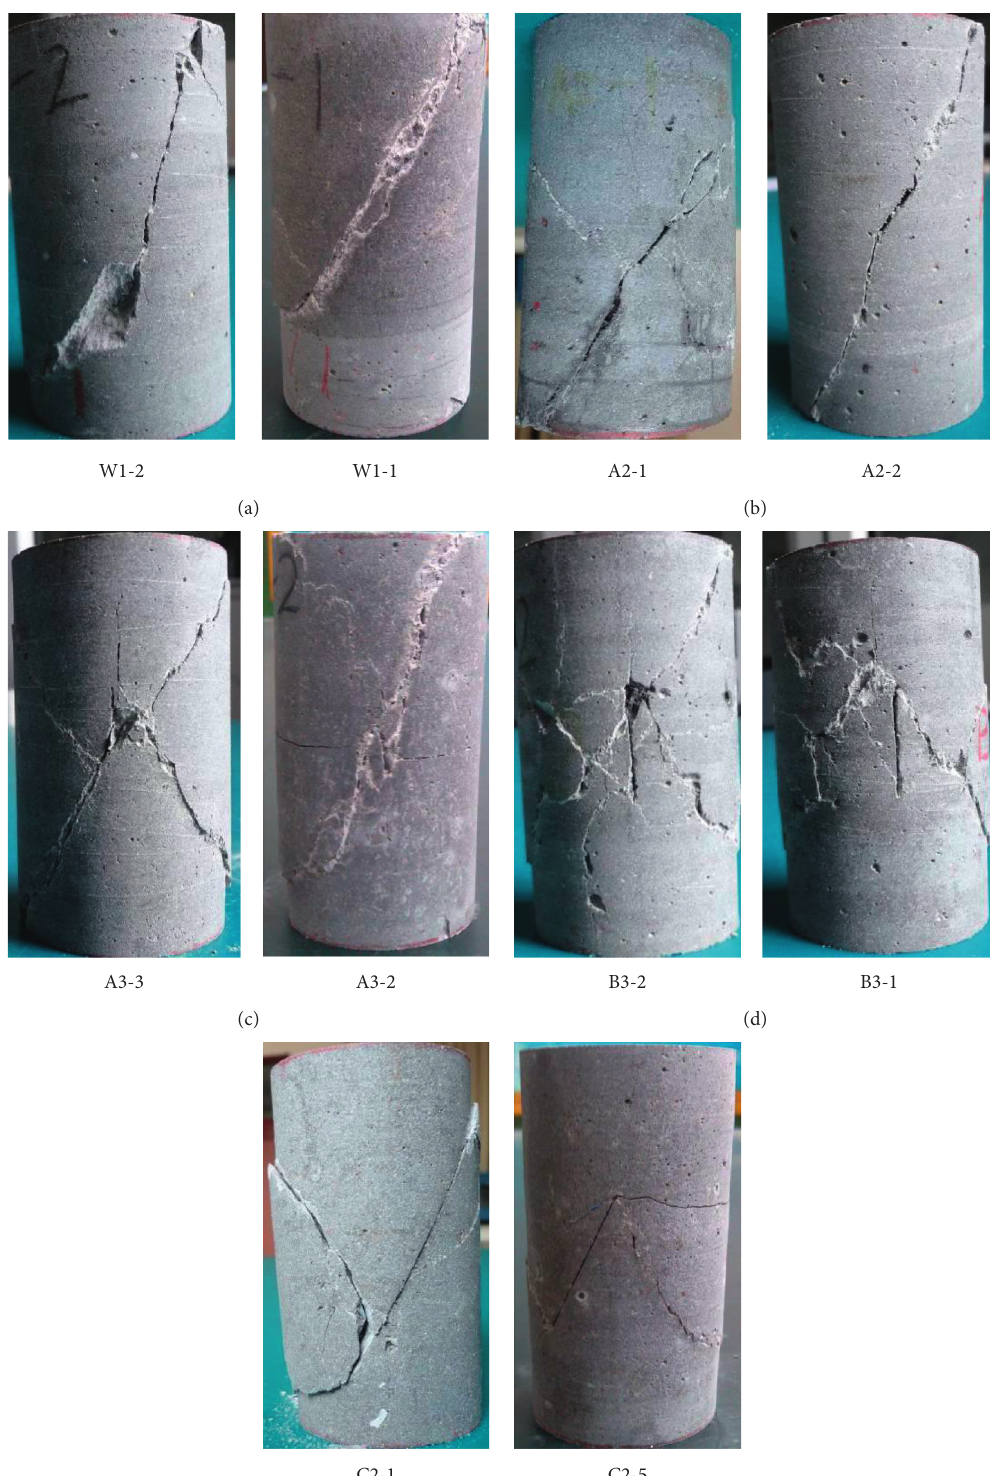
Figure 4: Failure modes of single-fractured rock specimens under the two type tests. (a) Failure modes of W1-2 and W1-1. (b) Failure modes of A2-1 and A2-2. (c) Failure modes of A3-3 and A3-2. (d) Failure modes of B3-2 and B3-1. (e) Failure modes of C2-1 and